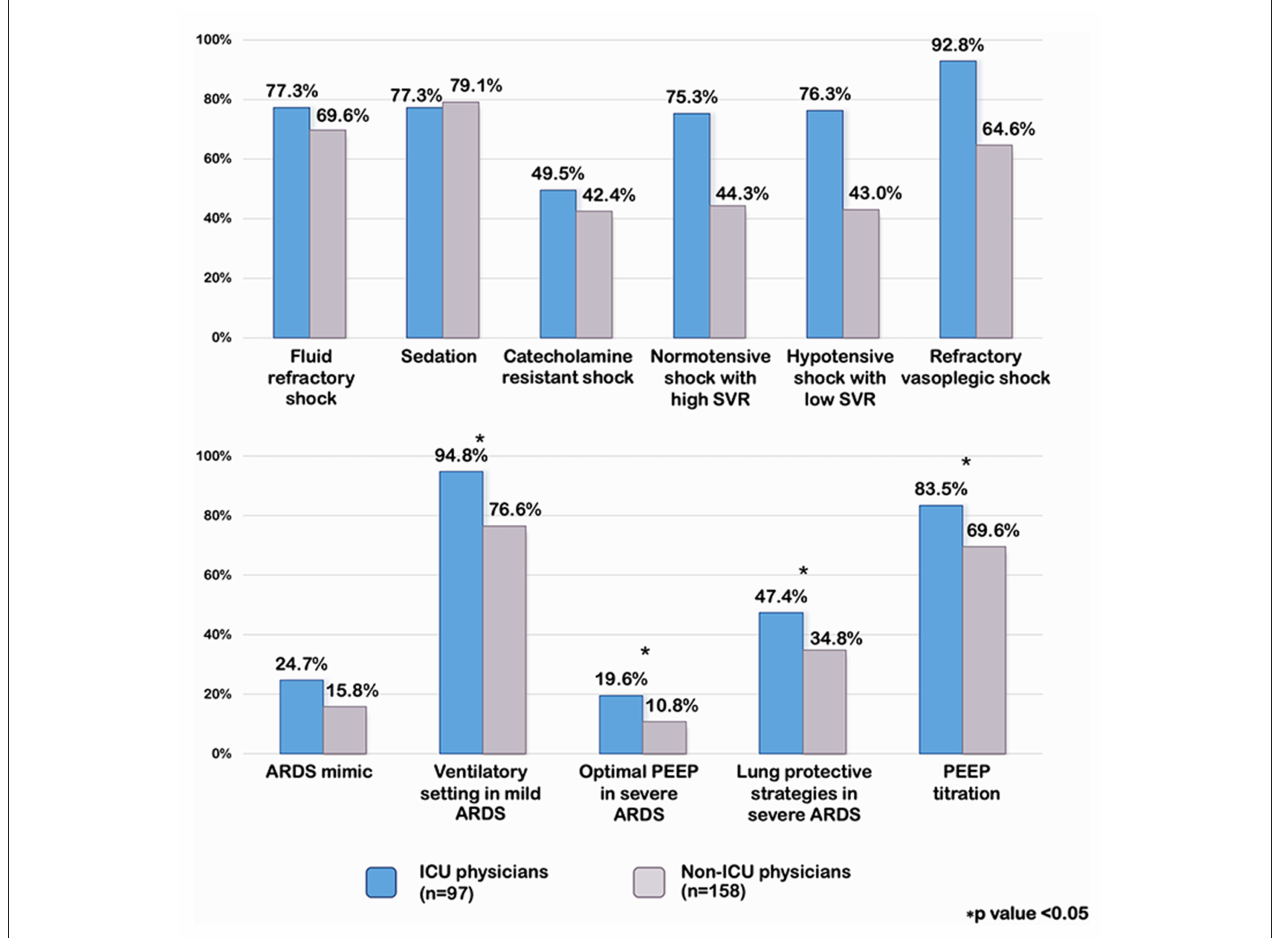
FIGURE 2 | Percentage of appropriate answers on septic shock and pARDS compared ICU and non-ICU physicians. SVR, systemic vascular resistance; PEEP, positive end expiratory pressure; ARDS, acute respiratory distress